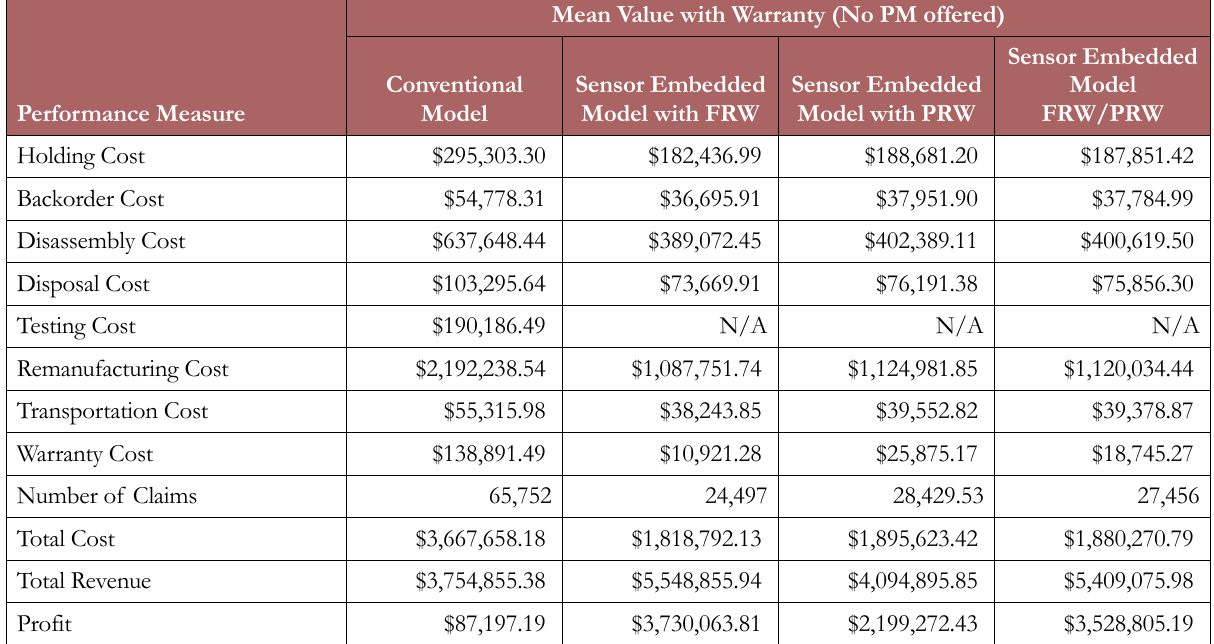
Table 6. Results of performance measures for different models with